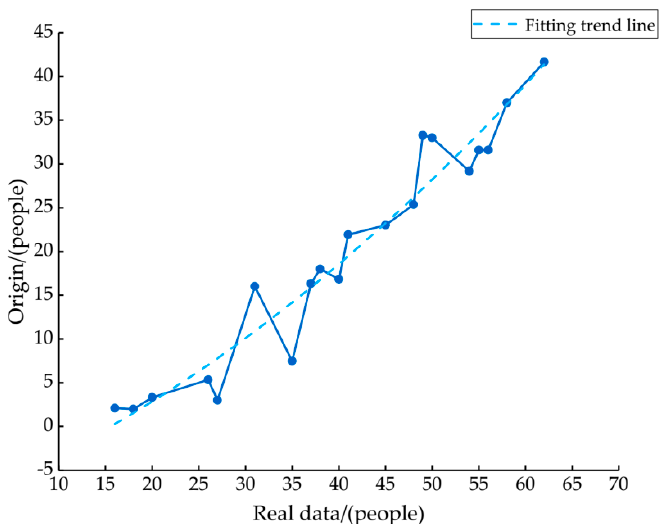
Figure 12. The relationship between real flow and the error between real flow and classification result of RF algorithm. result of RF